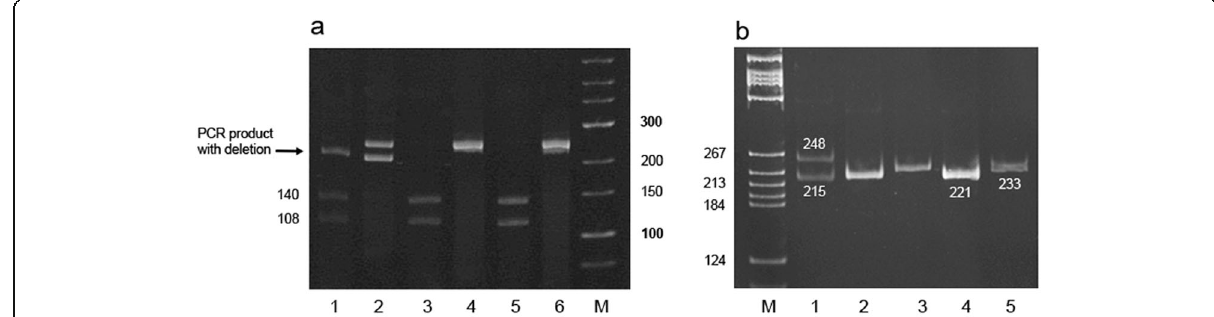
Fig. 2 PCR-RFLP detection of 26 exon SCN1A gene deletion. a М – GeneRuler Low Range DNA Ladder (Thermo Fisher Scientific, USA); 1 — the BamHI restriction results of PCR-amplified products of heterozygote with normal and shorted alleles of SCN1A 26 exon: 140 bp and 108 bp DNA fragments, which are the restriction products of normal allele, and the 215 bp DNA shorted DNA fragment; 2 — the 26 exon SCN1A gene PCR- amplified products (248 bp and 215 bp) of patient-carrier of deletion; 3 – 5 — the results of normal PCR-amplified product BamHI restriction: 140 bp and 108 bp DNA fragments; 4 – 6 — the 26 exon SCN1A gene PCR-amplified product (248 bp) of normal sample without mutation; b M – pBR322 DNA/BsuRI (HaeIII) Marker; 1 — the 26 exon SCN1 A gene PCR-amplified products (248 bp and 215 bp) of patient-carrier of deletion; 2, 4 — 221 bp